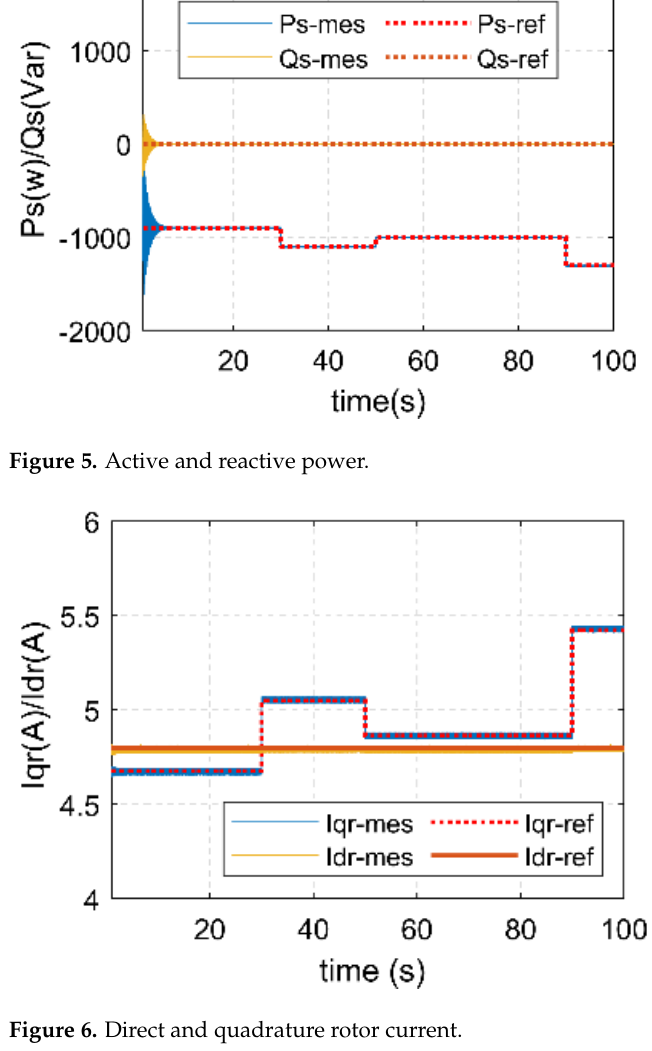
Figure 7. Stator current.